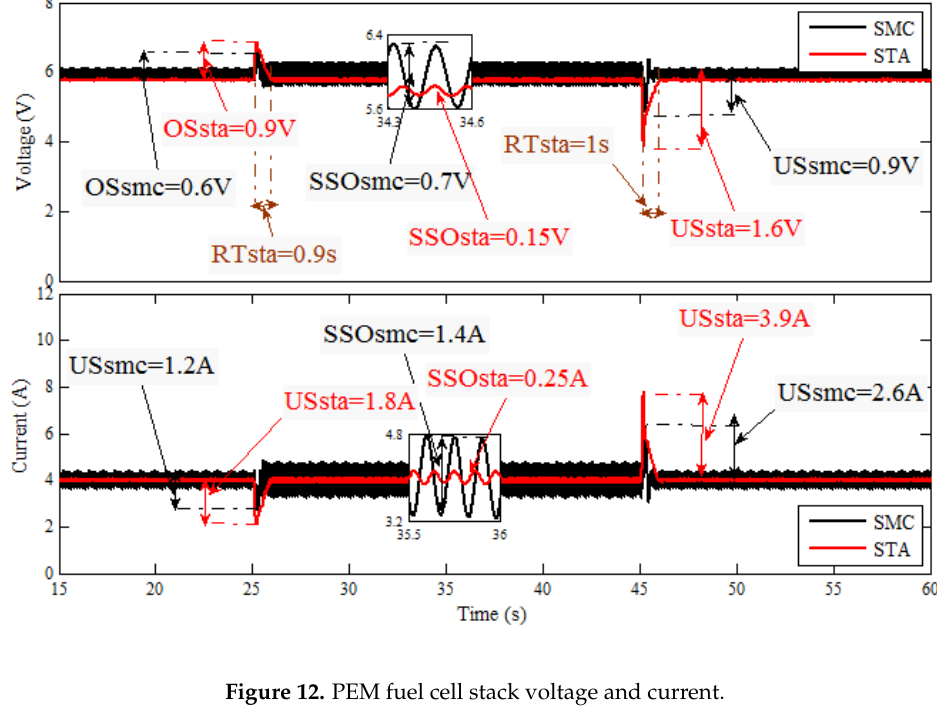
Figure 12. PEM fuel cell stack voltage and current.